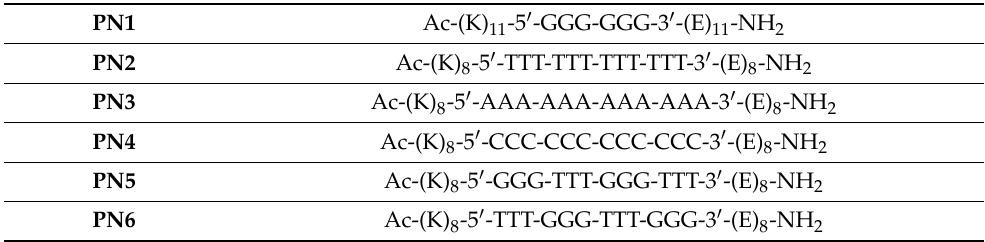
Table 1. The primary structure of the polypeptide-functionalized peptide nucleic acids (PNAs) and their corresponding generic names employed